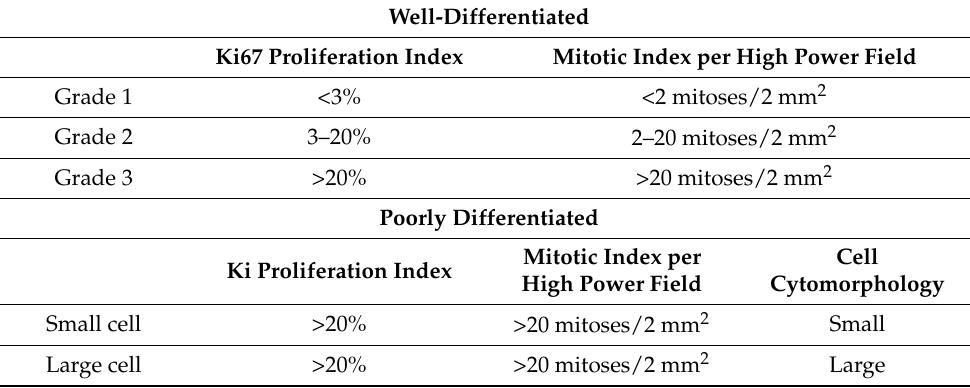
Table 1. World Health Organization (WHO) classification of